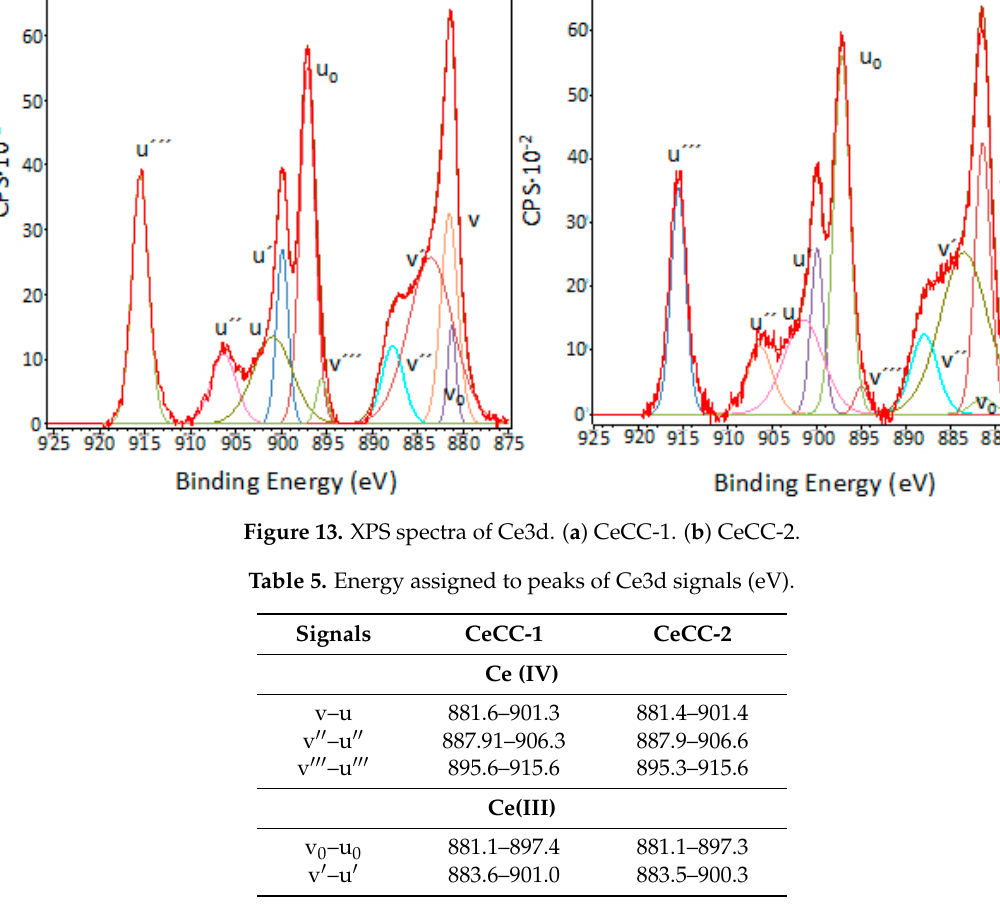
Figure 13. XPS spectra of Ce3d. ( a ) CeCC-1. ( b ) CeCC-2.